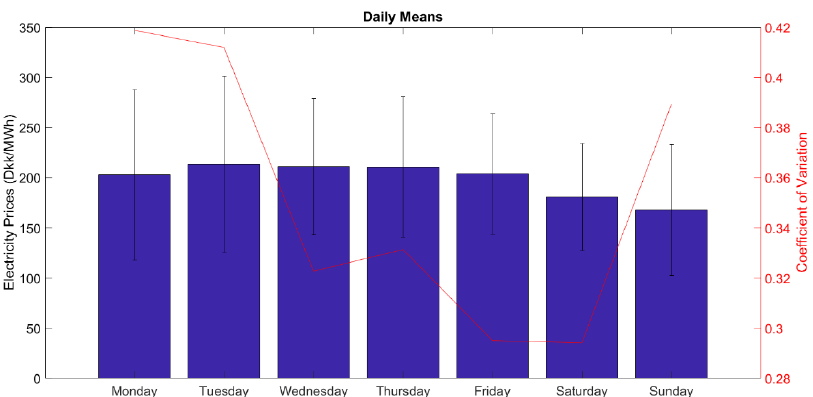
Figure 3. DK west day ahead electricity prices daily means, coefficient of variation, and standard deviation.